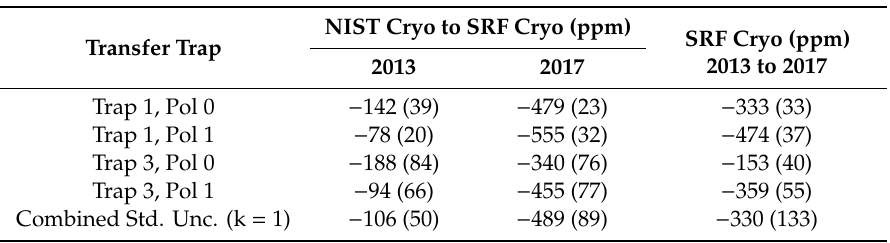
Table 2. NIST to LASP SRF Cryogenic Radiometer Transfer.